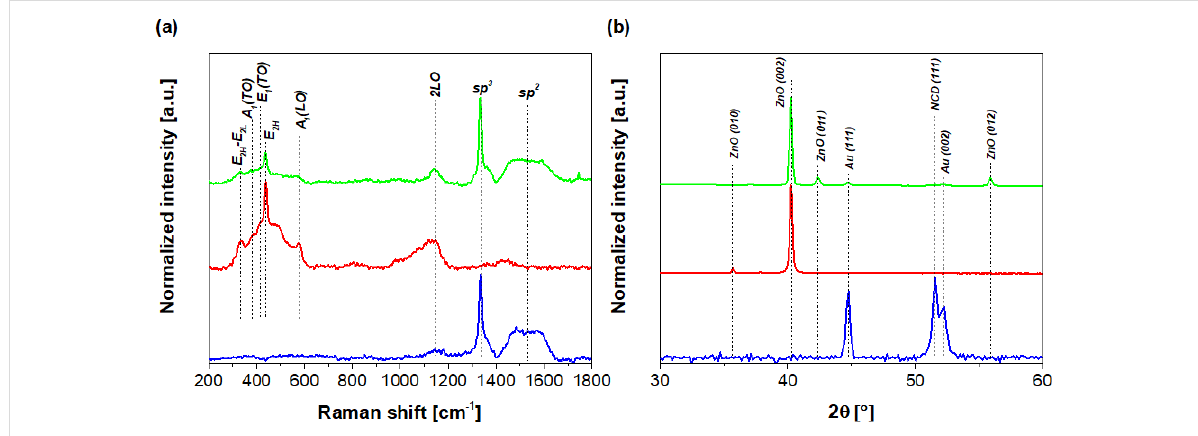
Figure 3: (a) Raman spectra and (b) X-ray diffraction patterns of sensor devices based on NCD thin film (blue line), ZnO NRs (red line), and hybrid structure ZnO NRs/NCD (green line).